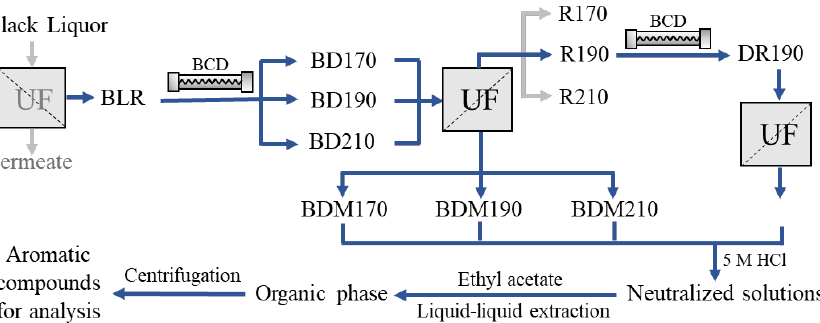
Figure 5. Schematic diagram of BLR sample production and the separation and preparation of phenolic compounds for analysis.